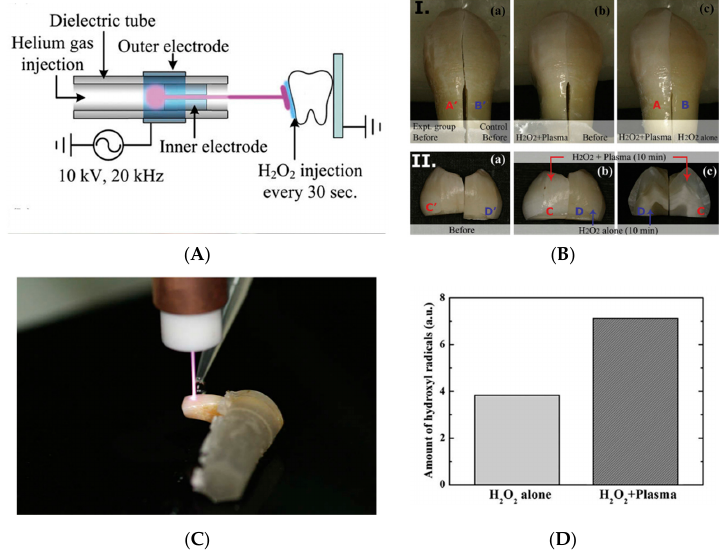
Figure 14. ( A ) Schematic of the plasma device and the tooth bleaching process performed by Lee et al. [234], ( B ) the external bleaching effect of plasma treatment, ( C ) configuration of the tooth bleaching experiment and ( D ) concentration of hydroxyl radicals in the solutions containing tooth before and after plasma treatment. Reprinted with permission from